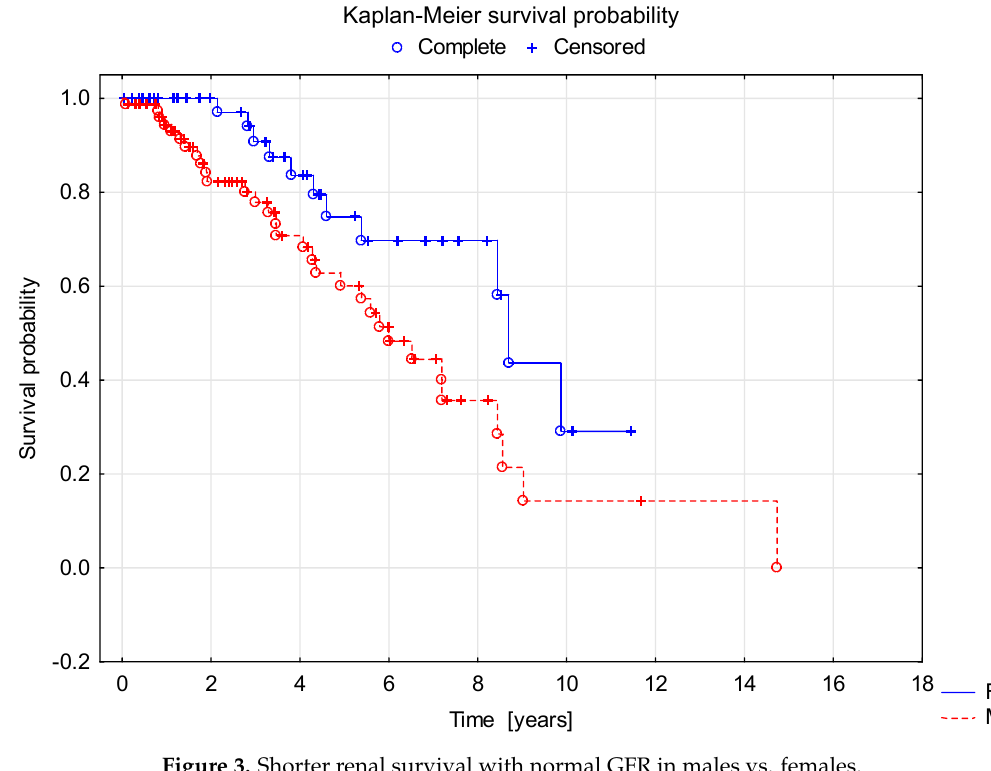
Figure 2. Shorter renal survival with normal GFR in Group B (intensity of C3 deposits = +2, +3, +4) vs. Group A (intensity of C3 deposits = 0, +1).